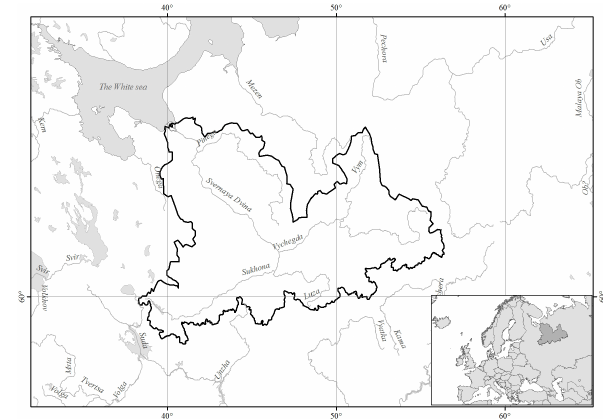
Figure 1. Location of the Northern Dvina River